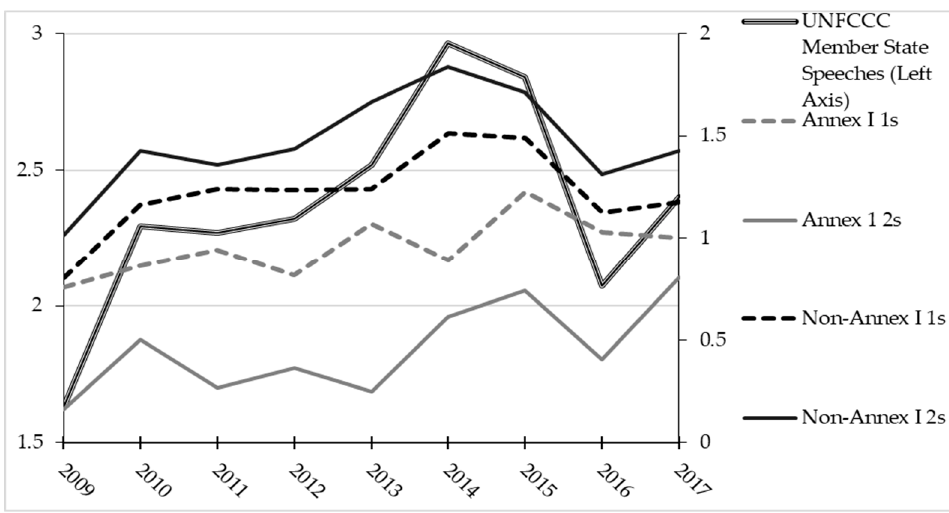
Figure 2. Average Climate Justice Mentions per Conference of the Parties (COP) Statement. (1s = brief mentions, 2s = multiple mentions/stronger